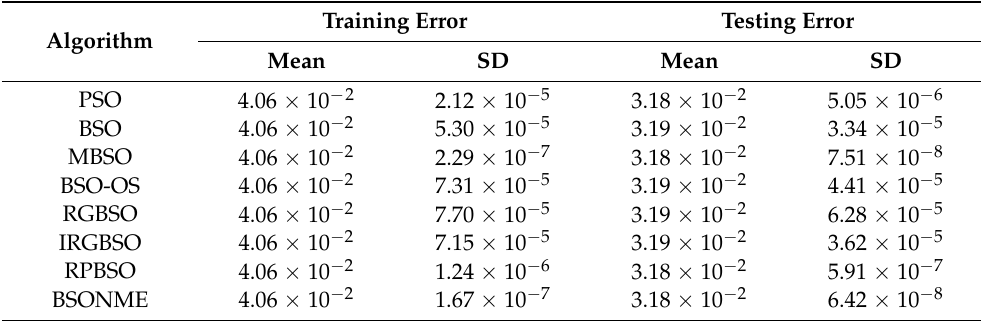
Table 17. Comparisons between PSO, BSO, MBSO, BSO-OS, RGBSO, IRGBSO, RPBSO, and BSONME on MSE of fund